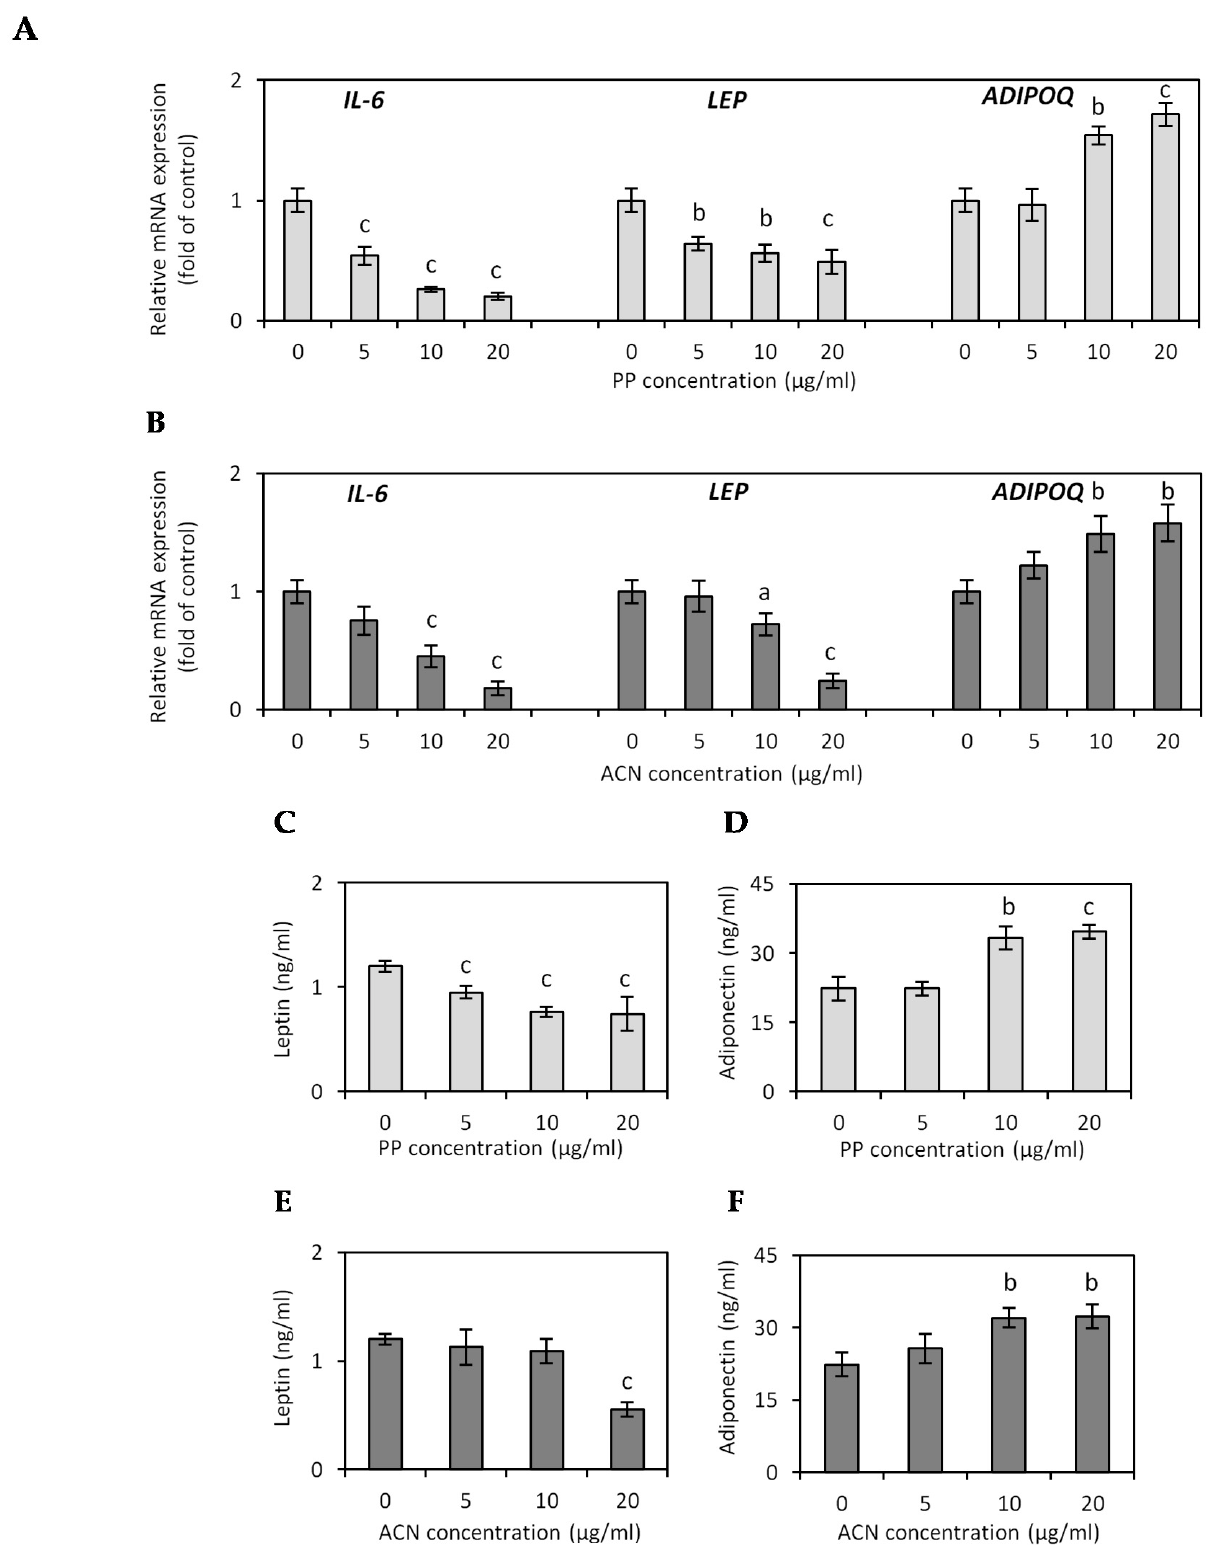
Figure 3. Effect of non-anthocyanin polyphenol (PP) and anthocyanin (ACN) fractions on adiponectin (ADIPOQ), leptin (LEP), and interleukin-6 (IL-6) gene expression ( A , B ), and adiponectin ( D , F ) and leptin ( C , E ) protein secretion by hypertrophied 3T3-L1 adipocytes. Data are the mean values ± SD ( n = 3). a p < 0.05, b p < 0.01, c p < 0.001.